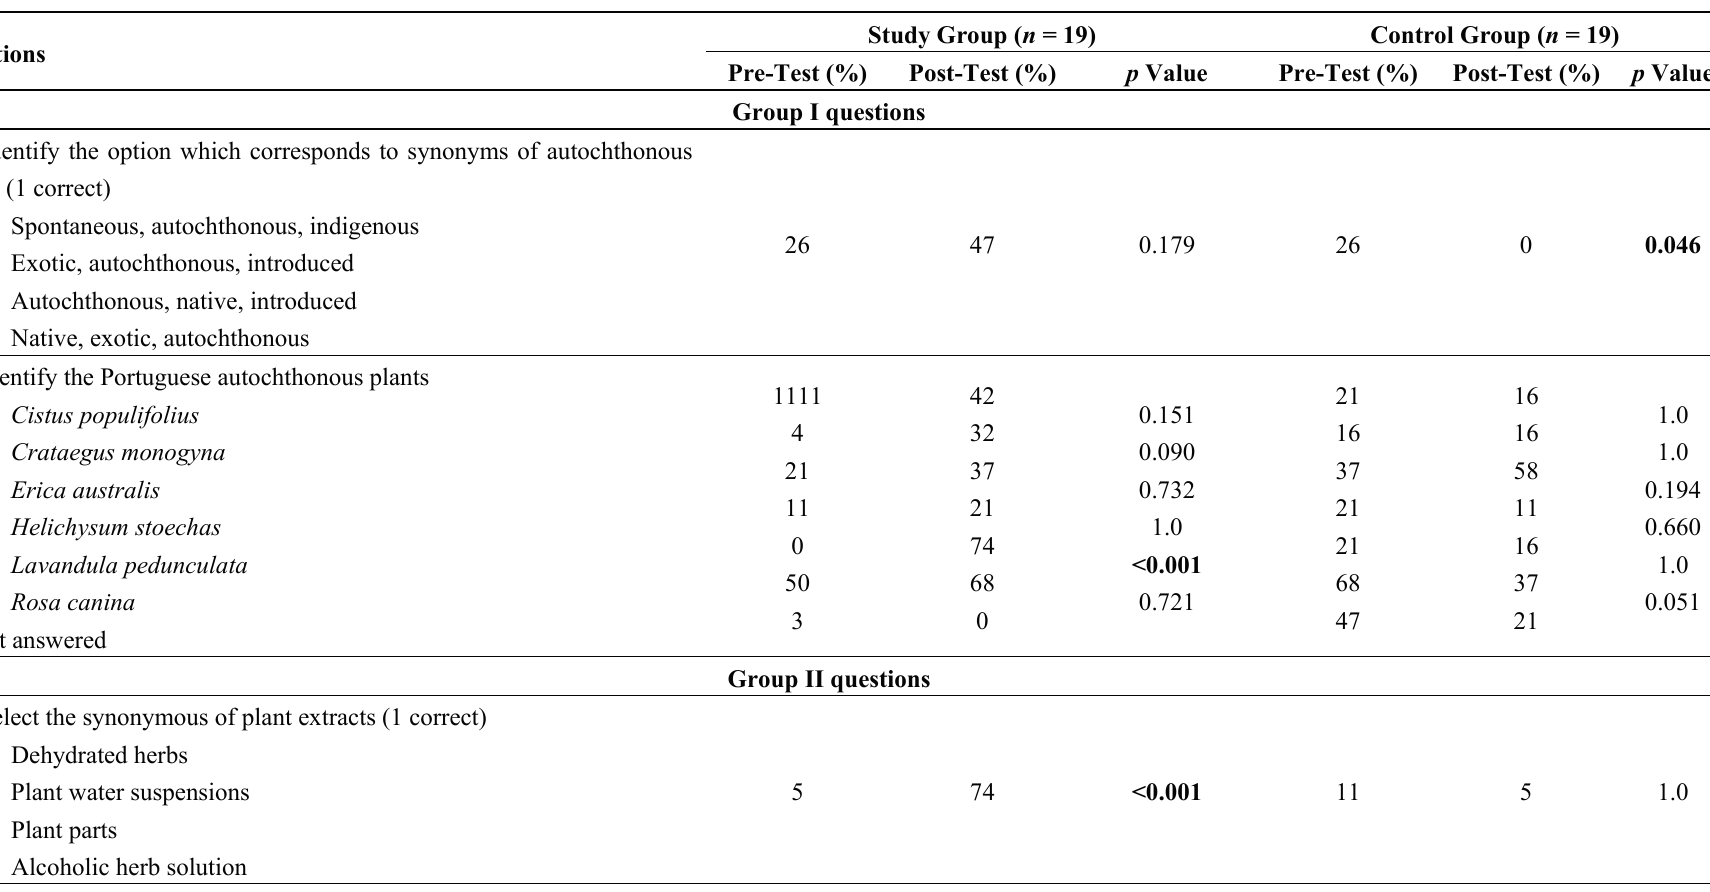
Table 3. Comparison of the correct answers between the pre- and post-test (control and study groups) to the questions described in Table 2.